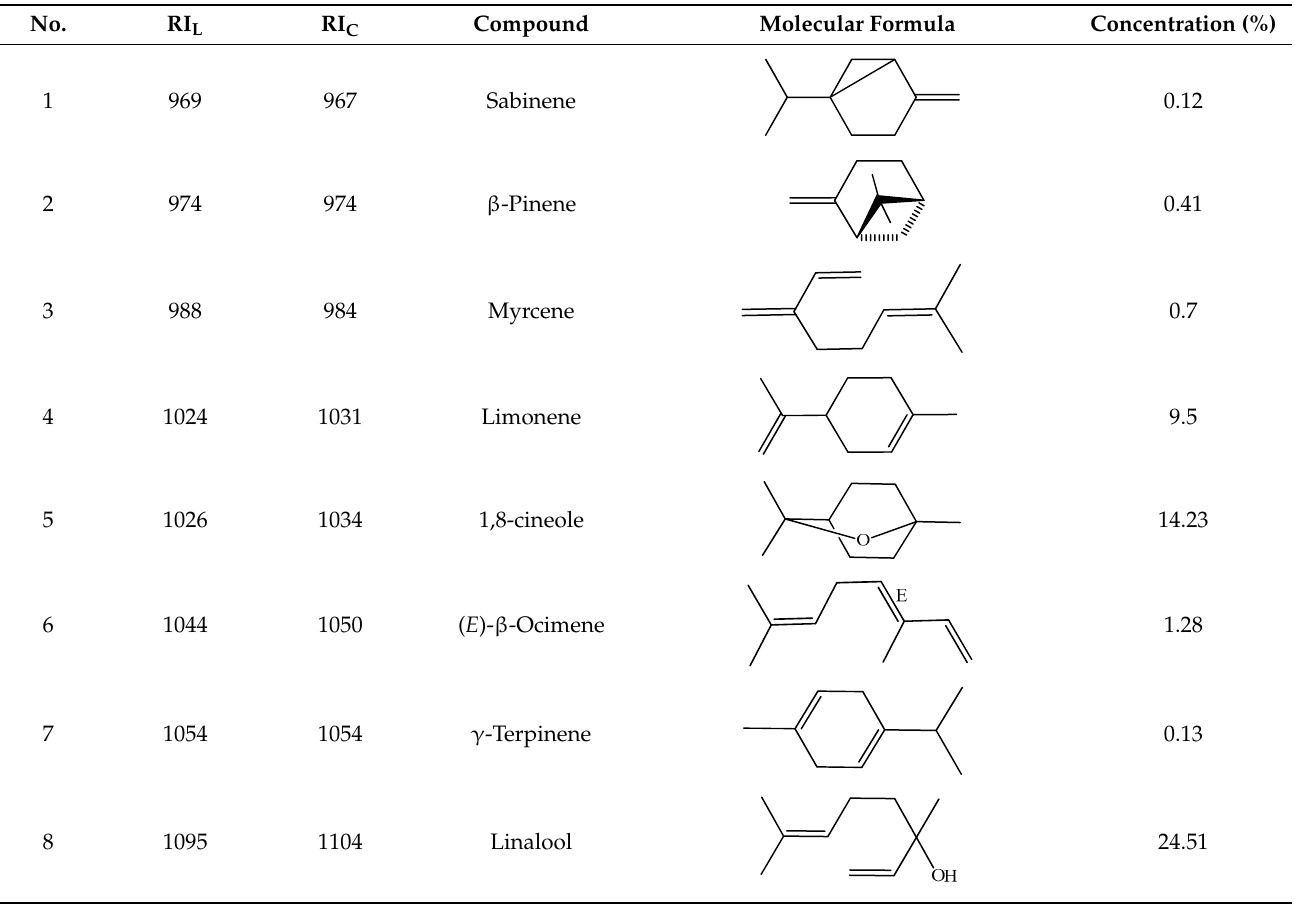
Figure 1. Ion-chromatogram of essential oil of O. basilicum var. minimum . Table 1. Chemical composition of O. basilicum var . minimum essential oil.